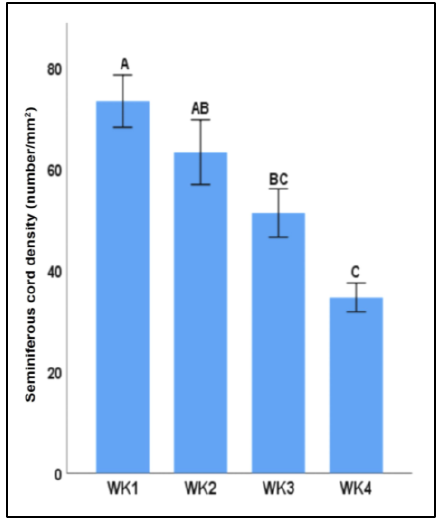
Figure 4. Seminiferous cord density of testicular tissue fragments over time. Density of seminiferous cords (number per mm 2 ) in tissue fragments decreased over time, where week 3 and 4 samples had lower density than those in week 1 samples. Data with different letters differ significantly ( p < 0.05).